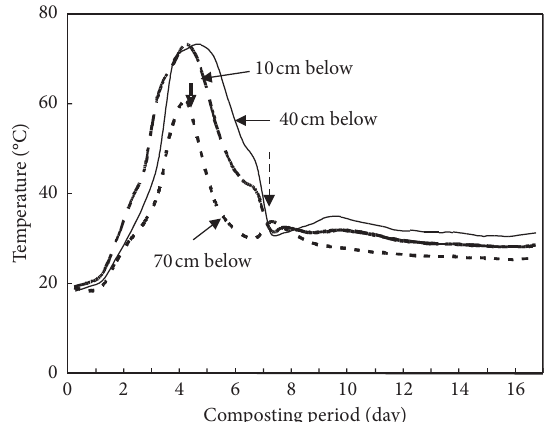
Figure 3: The changes of temperature in the reactor during composting of WS-PM. The waste sludge from a bean curd factory was mixed with newspaper chips as described in Figure 2, and the temperature of the reactor was monitored as described in Sections 2.2 and 2.3. On day 7, indicated with a broken line arrow, the aeration was ceased, and the WS-PM in the reactor was collected and replaced again after the thorough mixing of the sludge to check the subsequent 2 nd composting reaction. After setting the remixed WS-PM, aeration was started with the same condition as those in the first aeration. The broken line ---, the solid line –, and dotted line ···· represent fluctuation of the temperatures at depth of 10cm, 40cm, and 70cm, respectively, from the surface of the mixture in the reactor.